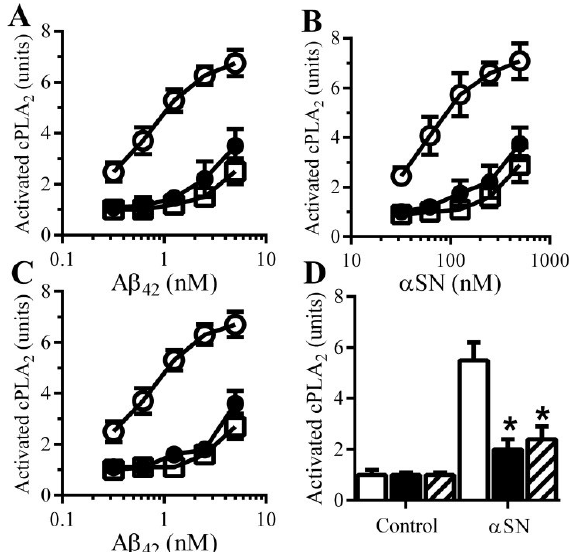
Figure 6. cAMP reduces Aβ and αSN-induced activation of cPLA 2 : The amounts of activated cPLA 2 in synaptosomes pre-treated with control medium (○), 100 μM pentoxifylline (●) or 10 μM rolipram (□) and incubated with Aβ 42 ( A ) or αSN ( B ) as shown. Values are means ± SD from triplicate experiments performed 3 times ( n = 9); ( C ) The amounts of activated cPLA 2 in synaptosomes pre-treated with control medium (○), 100 µM dibutyryl cAMP (□) or 100 µM 8-bromo-cAMP (●) and incubated with Aβ 42 as shown. Values are means ± SD from triplicate experiments performed 3 times ( n = 9); ( D ) The amounts of activated cPLA 2 in synaptosomes pre-treated with control medium (□), 100 µM dibutyryl cAMP (■) or 100 µM 8-bromo-cAMP (striped bars) and incubated with 200 nM αSN. Values are means ± SD from triplicate experiments performed 3 times ( n =